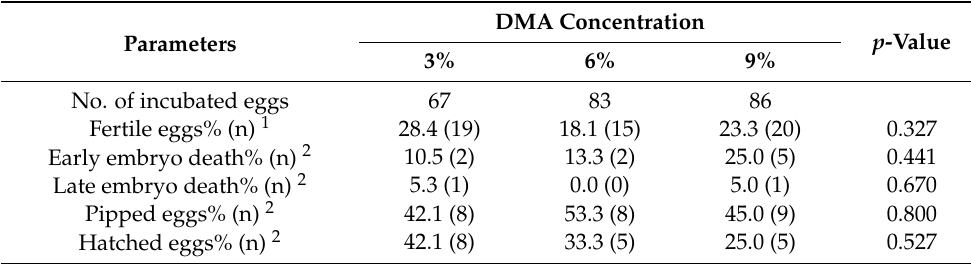
Table 4. Effect of dimethyl acetamide (DMA) concentration in semen freezing extender on the fertility traits of rooster sperm after thawing.